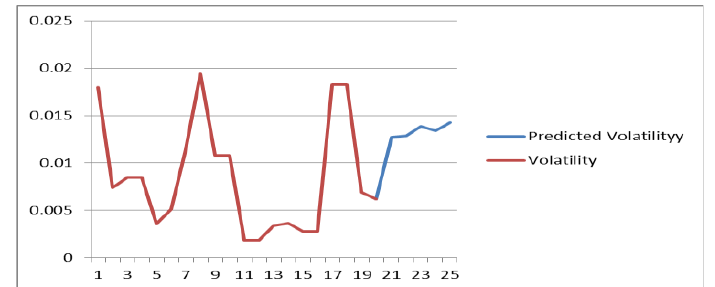
Figure.8. Short-term Prediction of NNAR-base